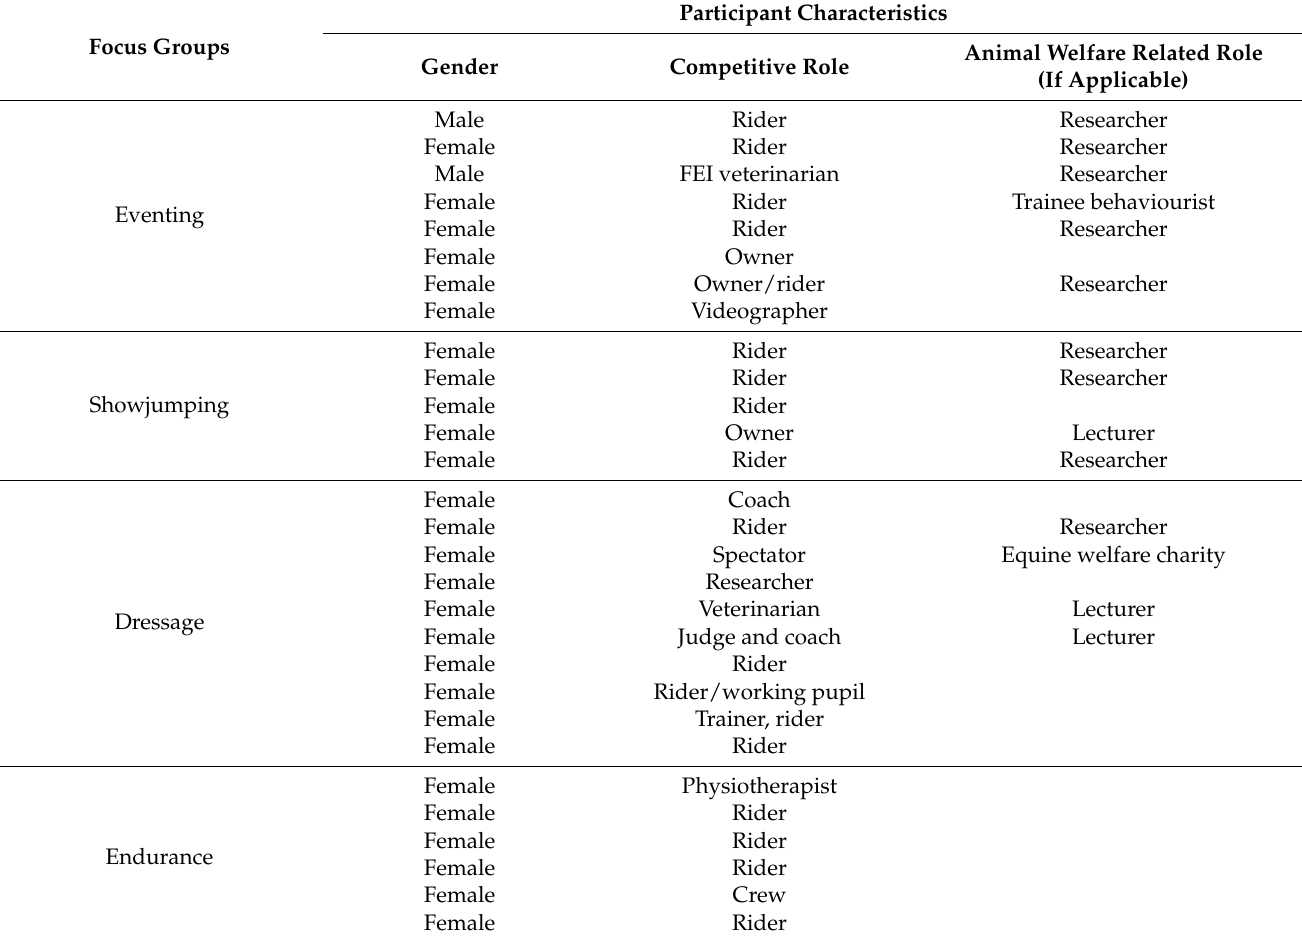
Table 1. Characteristics of participants within each of the focus groups (gender, competitive and welfare-related roles). FEI: F é d é ration Equestre